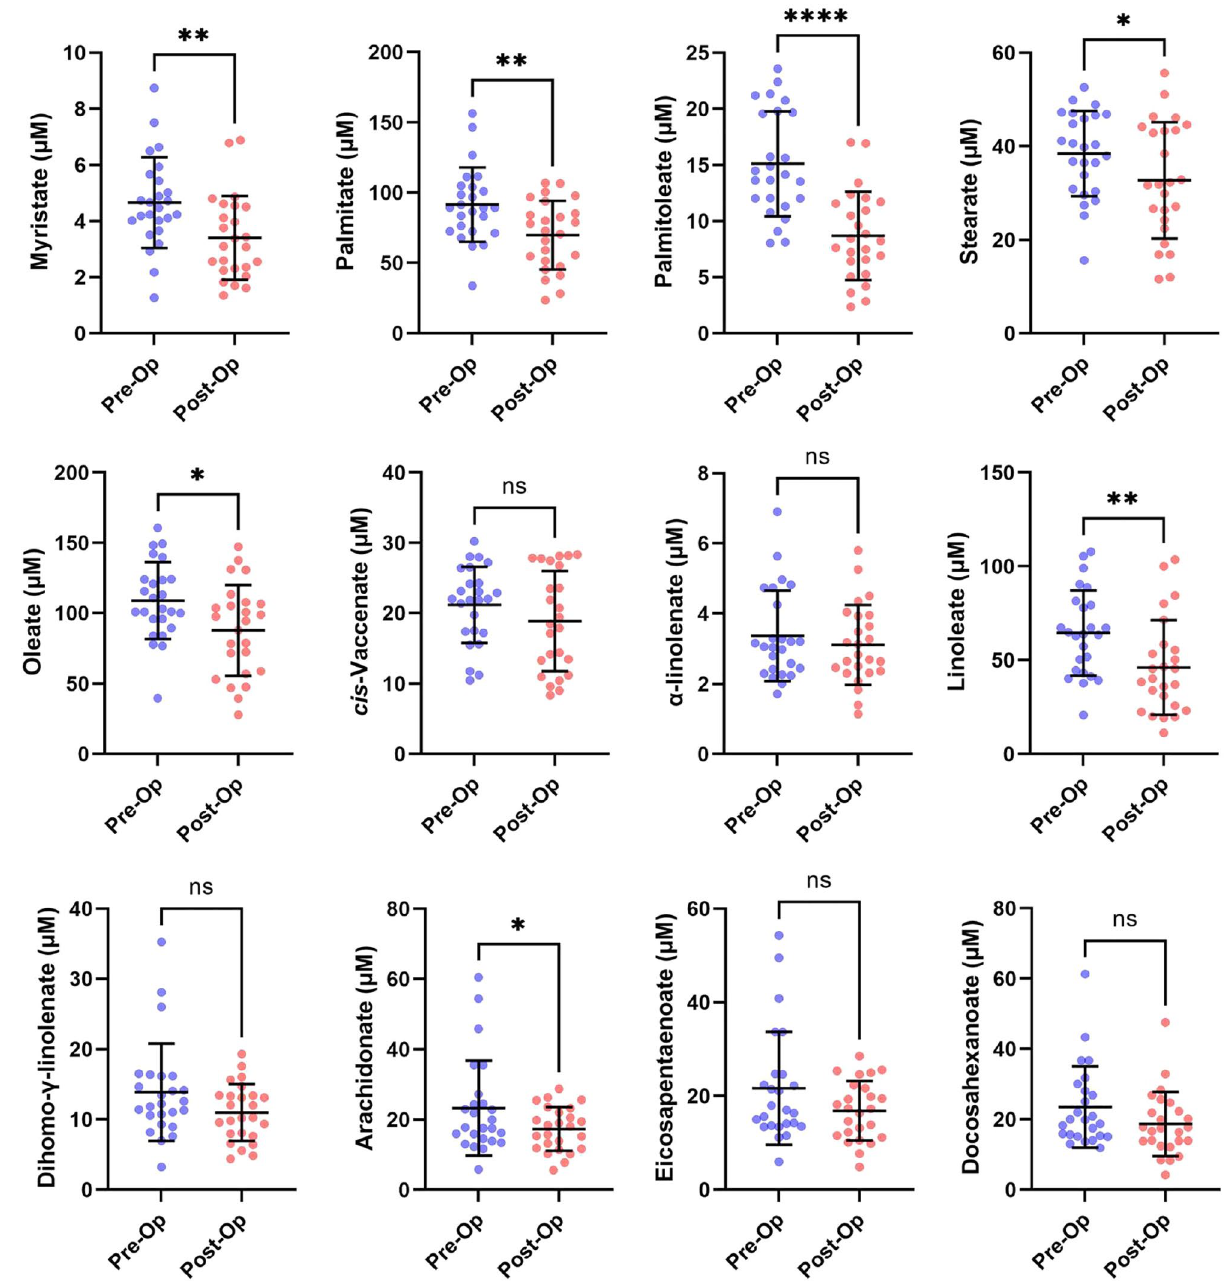
Figure 3. Mean plasma NEFA concentrations in participants before (Pre-Op) and 9 months after (Post-Op) bariatric surgery. Error bars show the mean values ± standard deviation. The p-values were calculated using paired T-test. Statistical significance is indicated as: ns not significant (p > 0.05), *p ≤ 0.05 and **p ≤ 0.01, ***p ≤ 0.001 and ****p ≤